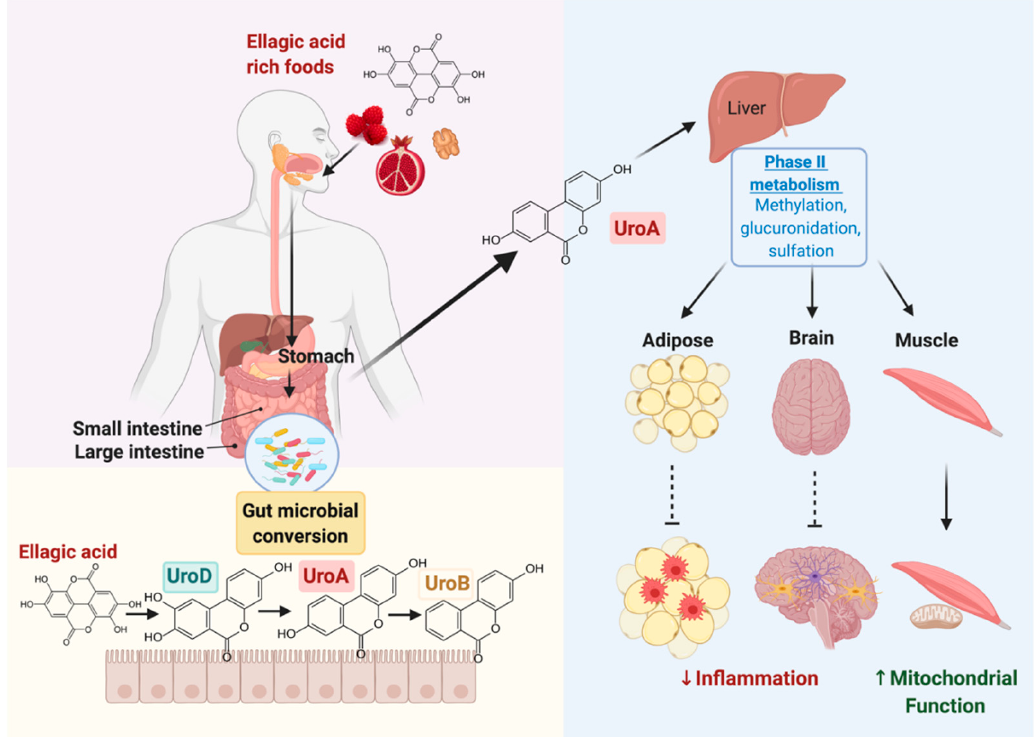
Figure 1. Ellagic-acid containing foods undergo gut microbial conversion to yield various forms of urolithins (Uro). Urolithin A (UroA) enters circulation and reaches the liver, to undergo phase II metabolism, to yield conjugated forms of UroA (such as methylation, glucuronidation, and sulfation). Conjugated UroA is able to reach peripheral tissues, including the adipose, brain, and muscle tissue, to prevent inflammation and increase mitochondrial function. Created with BioRender.com. UroA, urolithin A; UroB, urolithin B; UroD, urolithin D.